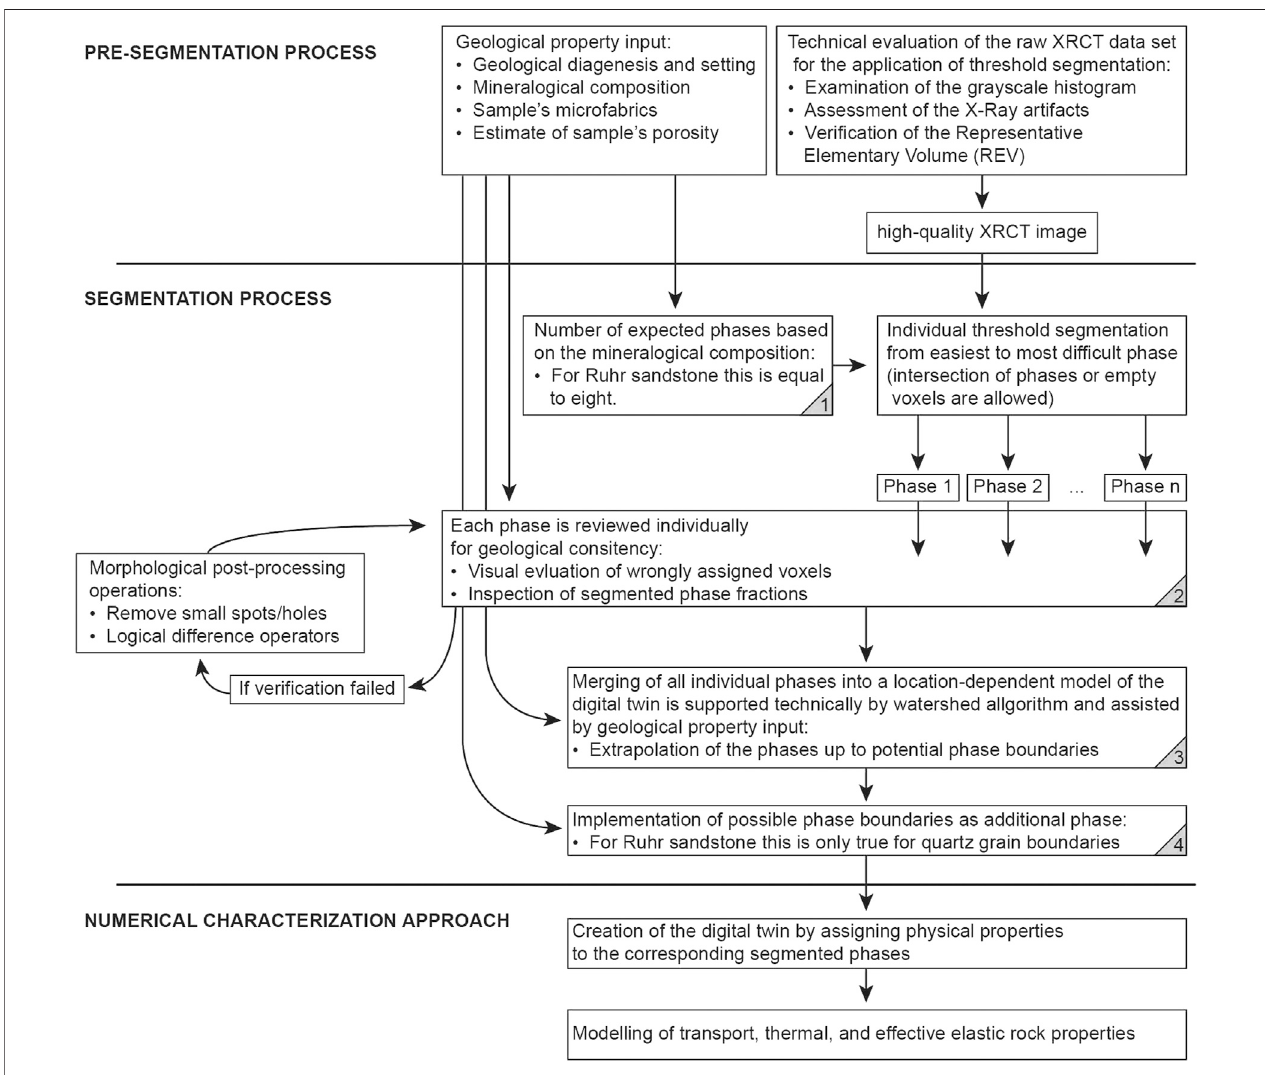
FIGURE 5 | Schematic representation of the geologically driven work fl ow. It should be noted that geological input parameters such as geological diagenesis, mineral composition, existing microstructure, or estimated sample porosity are repeatedly consulted in the segmentation process in order to obtain meaningful results. The so-called geological veri fi cation thus takes place a total of four times during the threshold segmentation.